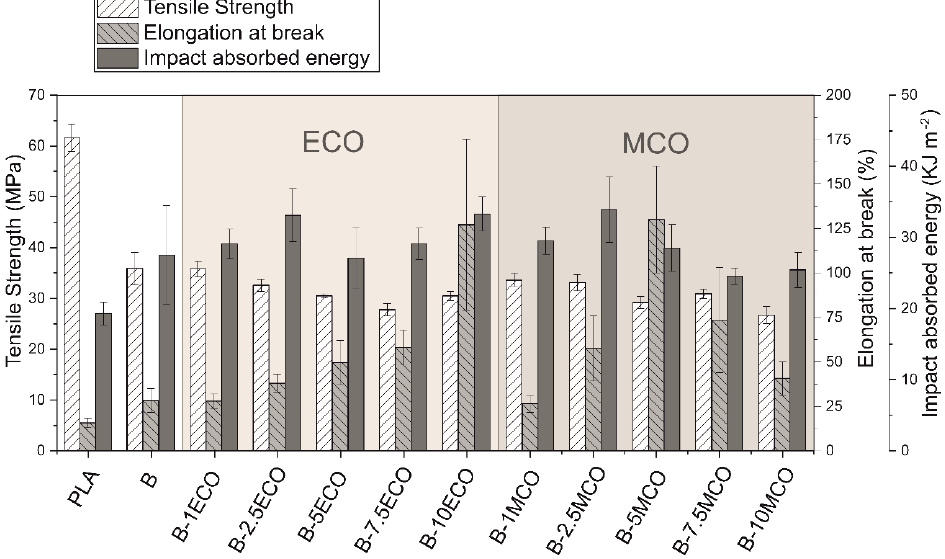
Figure 3. Effect of epoxidized and maleinized corn oil content on the tensile strength, elongation at break and impact energy of the PLA – PHB blend. Table 2. Summary of tensile and flexural properties and HDT/VST results of neat PLA, PLA – PHB blend and plasticized blends with a different ECO and MCO content.